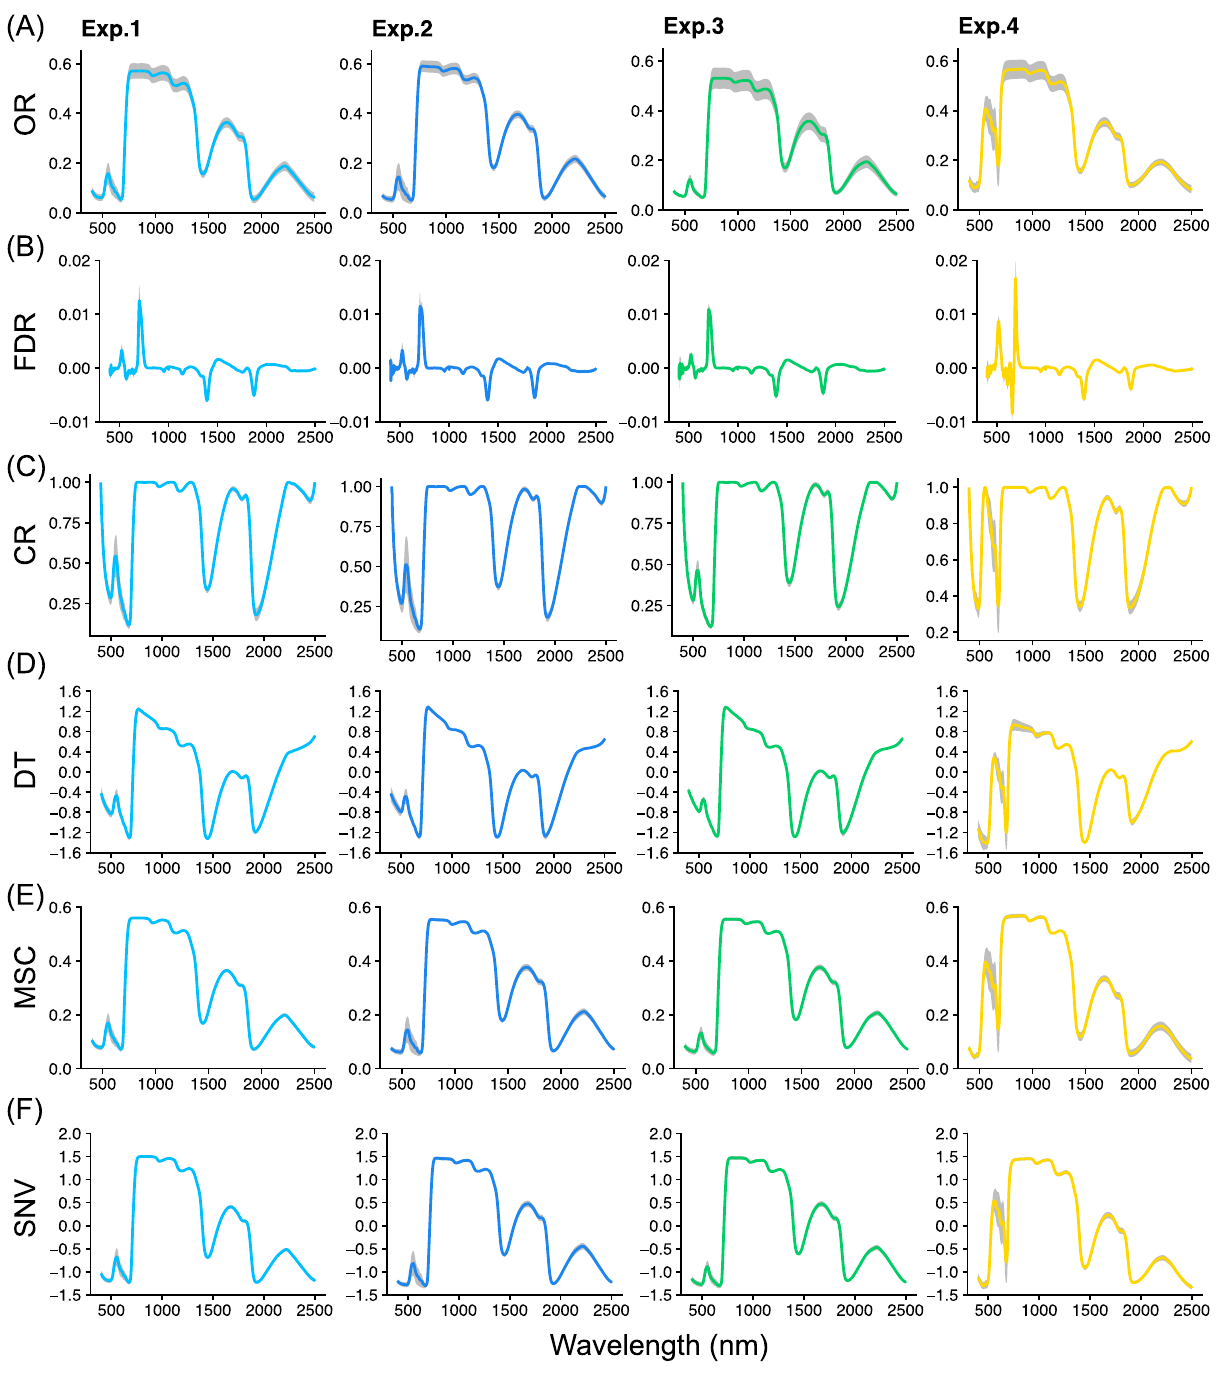
Figure 1. Pre-processing spectral patterns of original reflectance (OR) in tea leaves. Five pre-processing techniques were applied to the OR ( A ) base: first derivative reflectance (FDR, B ), continuum-removed (CR, C ), de-trending (DT, D ), multiplicative scatter correction (MSC, E ), and standard normal variate transformation (SNV, F ). Colors in spectra (Exp. 1, light blue; Exp. 2, blue; Exp. 3, green; Exp. 4, yellow) and gray indicate mean and standard deviation, respectively. Figures were visualized by the R package “ggplot2” ver.